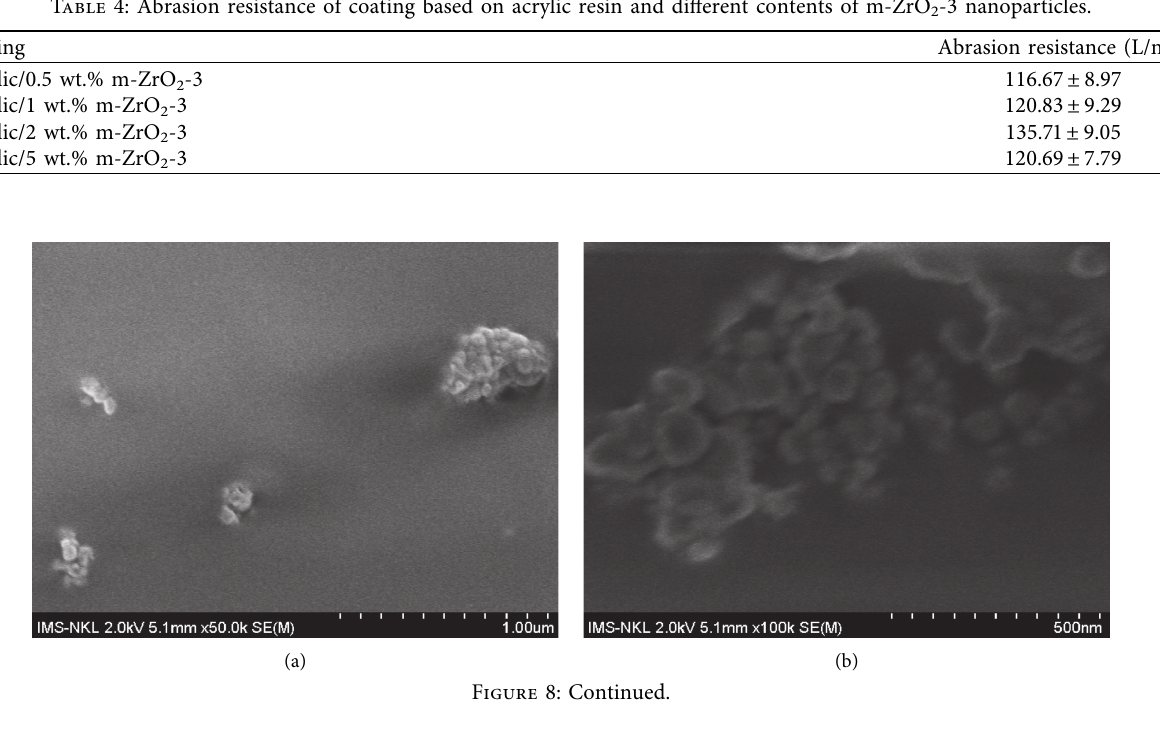
2 -3 nanoparticles.